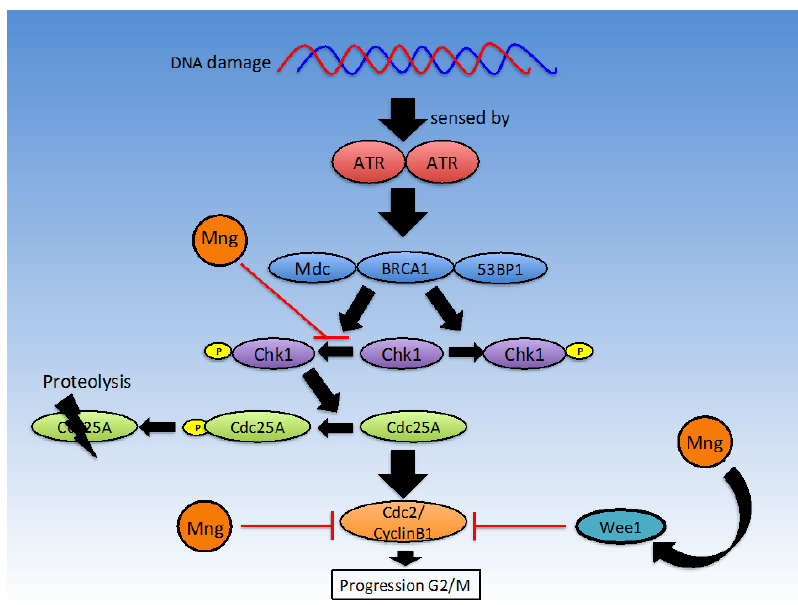
Figure 3 . Mangiferin affects the molecular events leading to cell cycle G 2 /M phase arrest (Figure adapted from [71]).